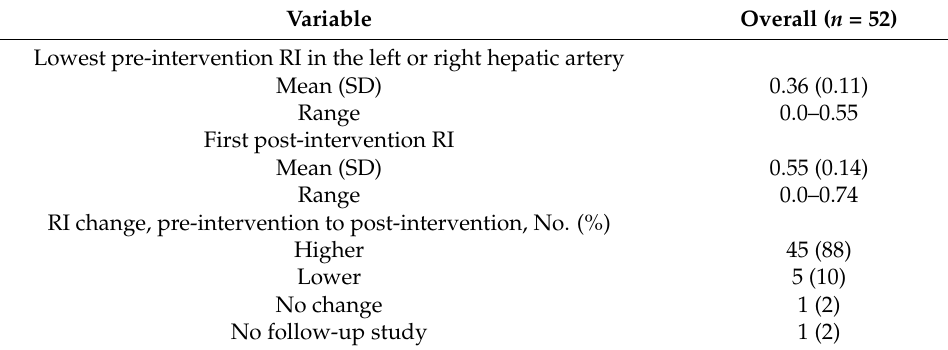
Table 3. RIs before and after primary stent placement. Variable Overall ( n = 52) Lowest pre-intervention RI in the left or right hepatic artery Mean (SD) 0.36 (0.11)